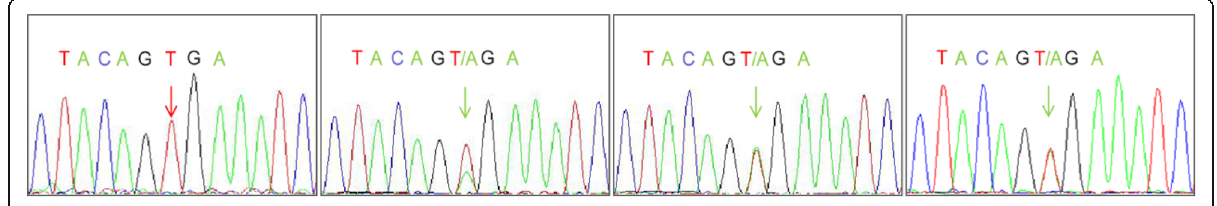
Fig. 5 Molecular features of sialadenoma papilliferum. BRAF wild type (Red arrow); BRAF p.V600E c.1799 T > A (Green arrow). BRAF mutation is confirmed in three of four cases by Sanger